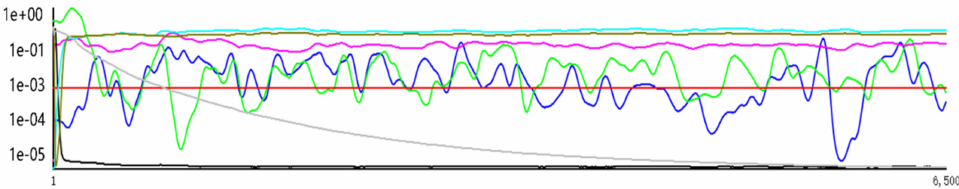
Figure 8. The convergence curve for case 4